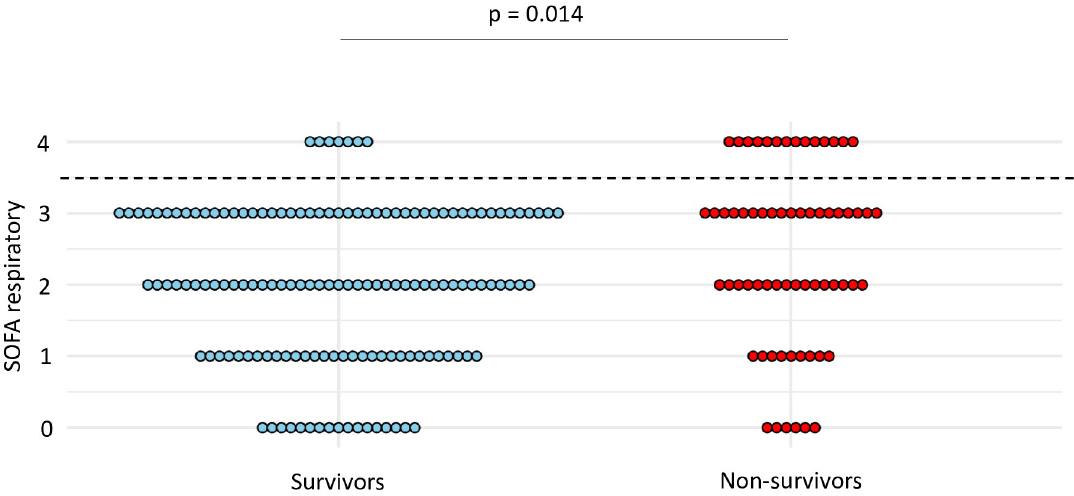
Fig 6. Dot plots of respiratory SOFA in survivors and non-survivors. Values of respiratory SOFA are shown as single dots for each patient. The dash line separates patients with a respiratory SOFA = 4 from those with a respiratory SOFA < 4. SOFA sequential organ failure